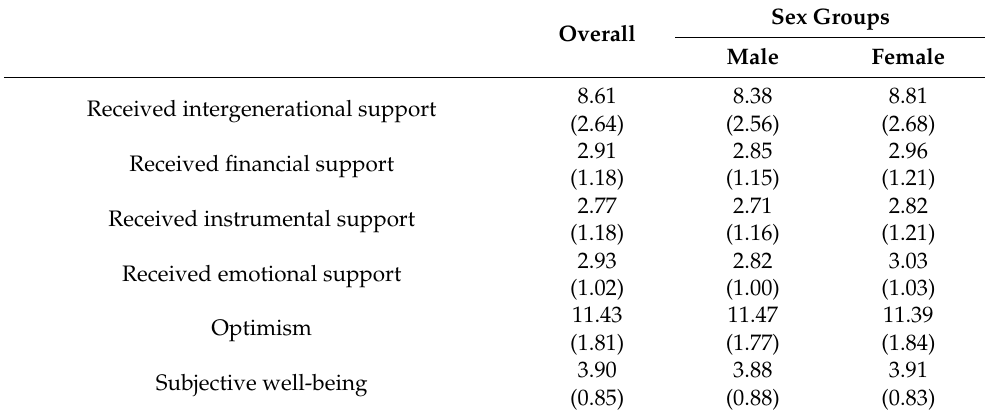
Table 1. Means and standard deviations of each scale by sex group (standard deviations in parenthesis).